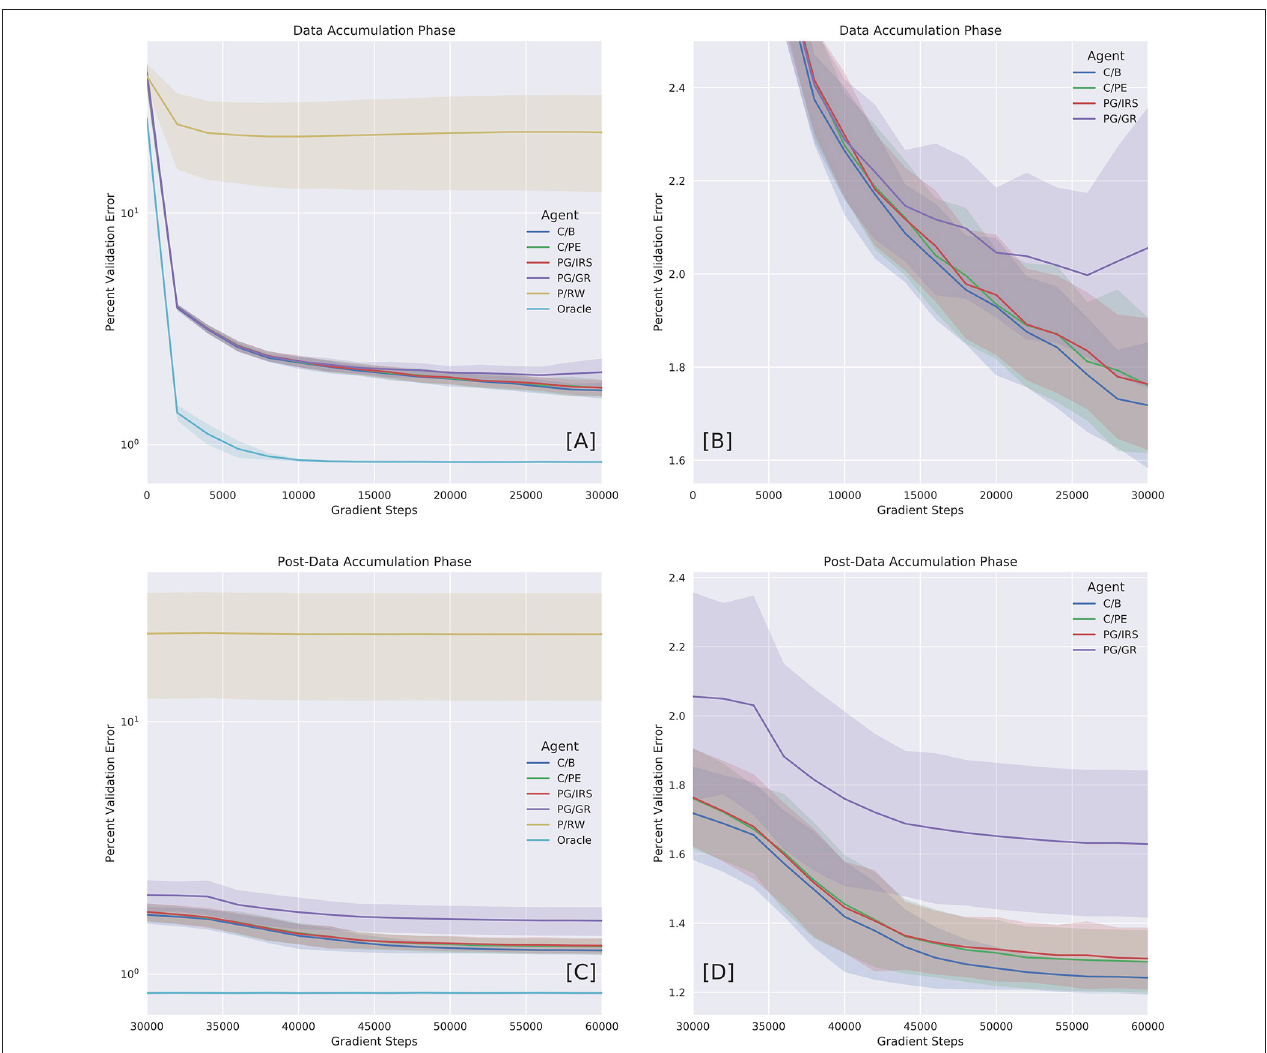
FIGURE 4 | Benchmarking model variants with oracle dataset. Performances were reported in error percentage ( also, see Table 2) . (A) Performance as a function of time during Data Accumulation Phase (DAP). (B) Close-up on curious variants (C/B, C/PE, and PG/IRS), as well as policy gradients (PG/GR) informed by surrogate reward statistics. The C/PE and PG/IRS variants performed similarly, but differed significantly from C/B (Table 2) . (C) Performance over time during post-DAP. (D) Close-up on post-DAP performances for curious variants and